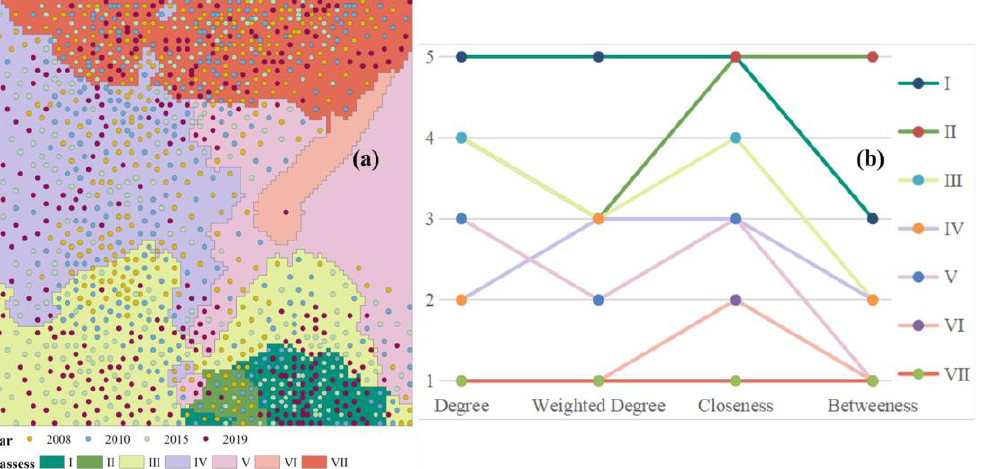
Figure 6. Results of the secondary clustering: ( a ) 7 types of clusters; ( b ) network feature types of the 7 clustering results.